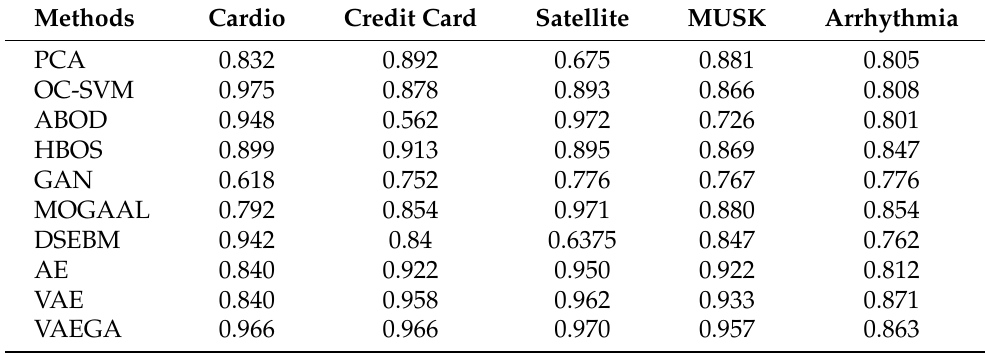
Table 3. AUC of 10 models for outlier detection on 5